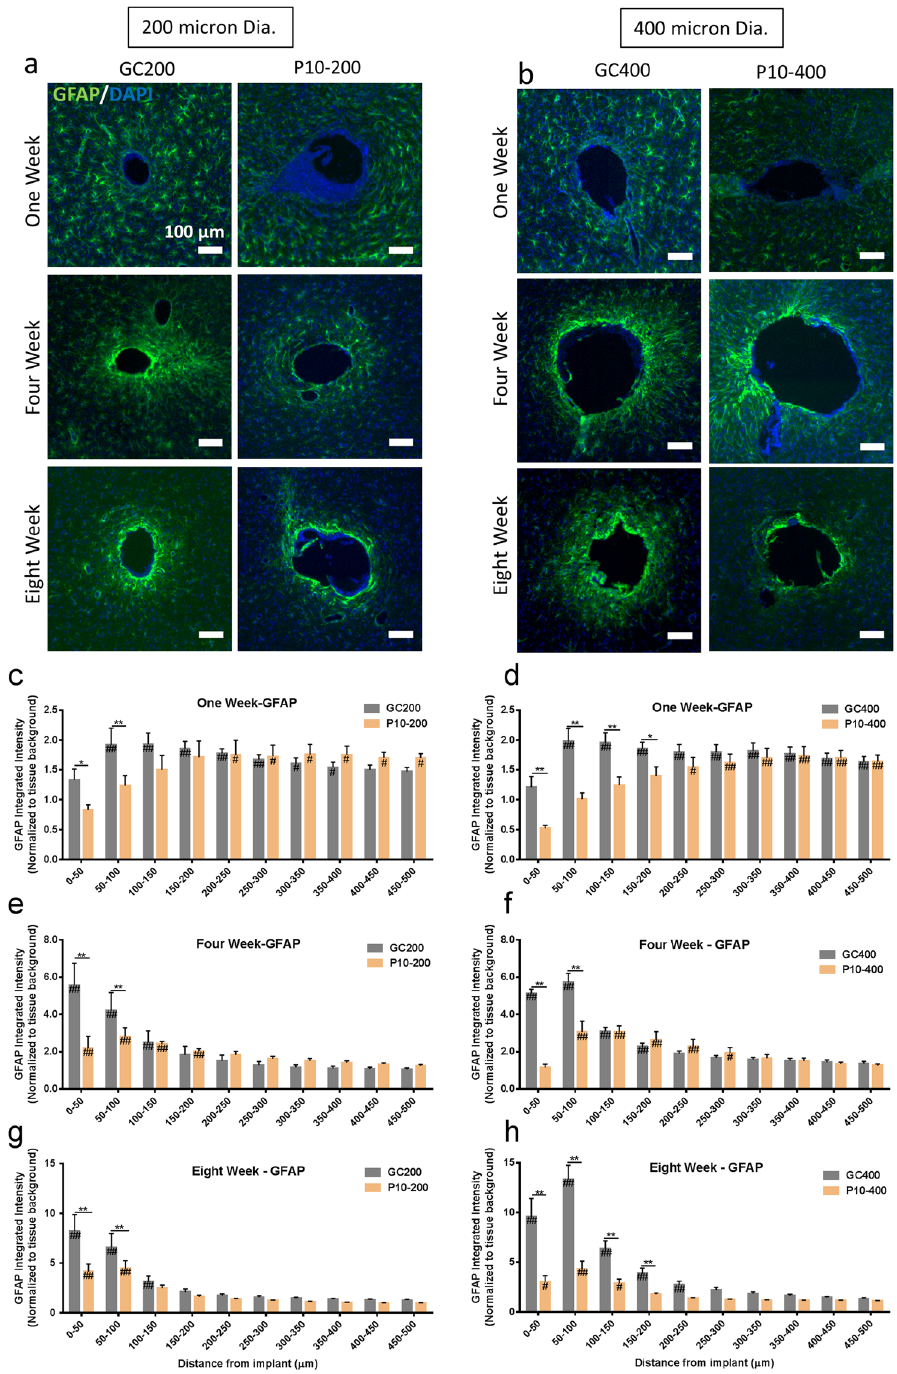
Figure 3. Effect of Implant Modulus on Scarring Soft implants produce less glial scarring compared to hard implants when diameter is held constant. GFAP expression was quantified as a function of distance from the device tissue interface for implants for PEG hydrogel coated implants (E ≈ 10 kPa) and glass capillaries (E ≈ 70 kPa) of identical diameter (d = 200 um and d = 400 um) at 1, 4, 8 weeks post implantation. ( a , b ) Representative immunofluorescence images depicting the GFAP reactivity at the implant location at 1, 4, and 8 weeks post implantation. Scale bar = 100 μ m. Glial scarring was significantly reduced for 200 μ m and 400 μ m hydrogel coated implants at 1, 4, and 8 weeks post implantation. ( c , d ) The average GFAP reactivity as a function of distance from the device at 1 week post implantation. ( e , f ) The average GFAP reactivity as a function of distance from the device at 4 weeks post implantation. ( g , h ) The average GFAP reactivity at eight weeks post implantation. ** p < 0.01, * p < 0.05 indicates a statistically significant difference between cohorts at a given distance from the implant interface. ## p < 0.01, # p < 0.05 indicates a statistically significant difference compared to background. Cohort sizes (1 wk, 4 wk, 8 wk), GC200 = (6, 5, 7) P10–200 = (6, 7, 7), GC400 = (6, 5, 10), P10–400 = (6, 6, 6). Each n corresponds to an individual animal. A minimum of four sections were analyzed per